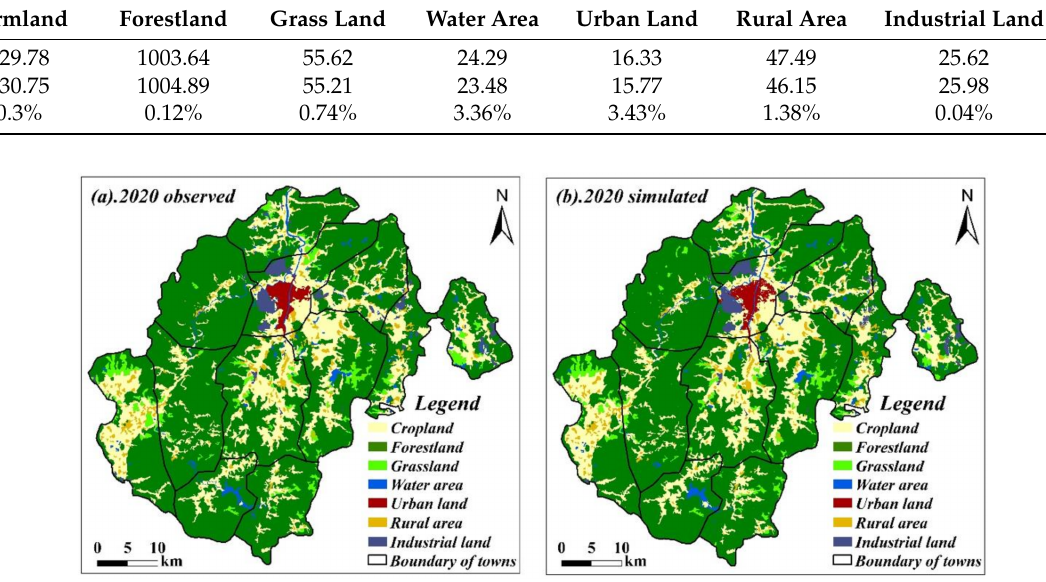
Figure 5. The comparison between the simulated LULC and the observed LULC in